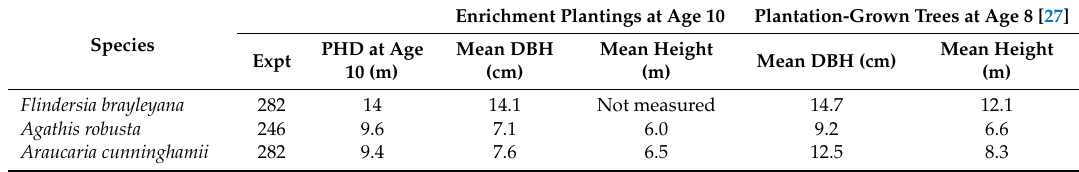
Table 3. A comparison of the early-age growth of three commercially desirable species in the enrichment planting experiments in which they grew best, with their expected growth rates in plantations.